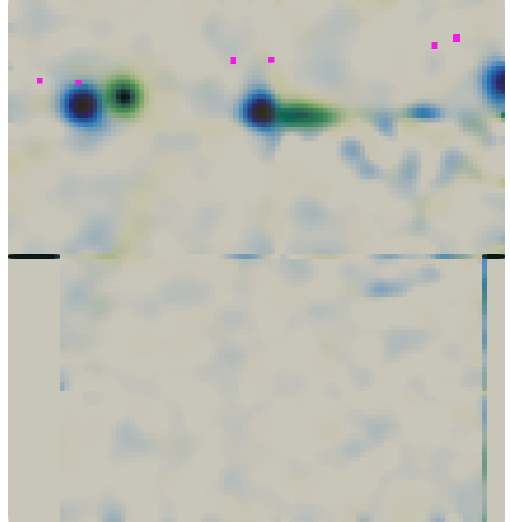
Figure 7. Experimental tip vortices’ position on steps 1 (green) and 5 (blue). Vorticity perpendicular to the plane shown from 0 to 300 1 / s. Pink dots represent the tip vortices from the panel method sim- ulation.